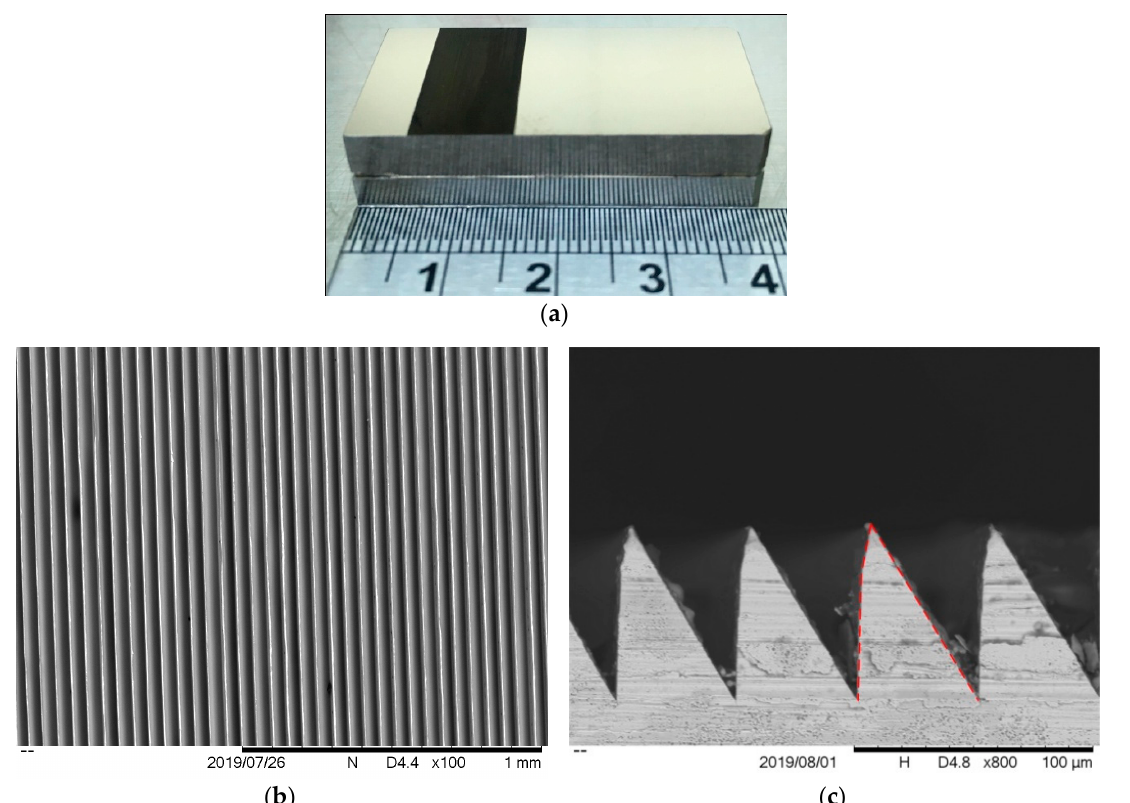
Figure 9. Fabrication result of the electroless nickel mold. ( a ) Photograph of the mold. ( b ) Top and ( c ) cross-sectional SEM views.